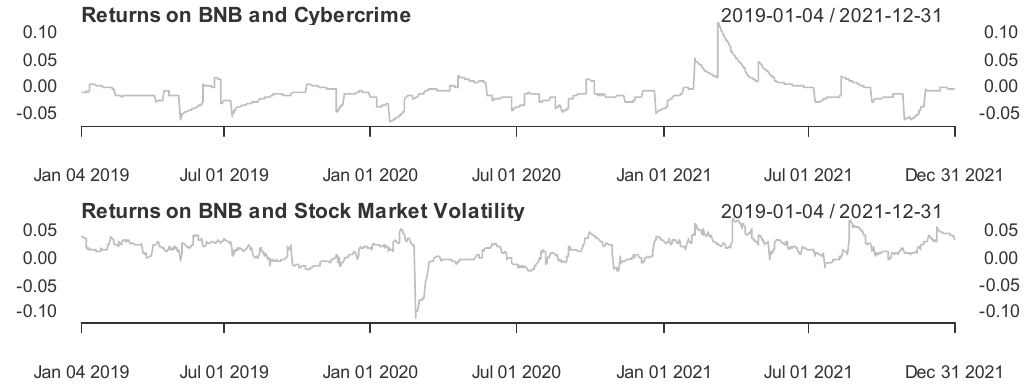
Figure 3. Time ‐ varying correlation coefficients between returns on BNB and cybercrime and stock market volatility .